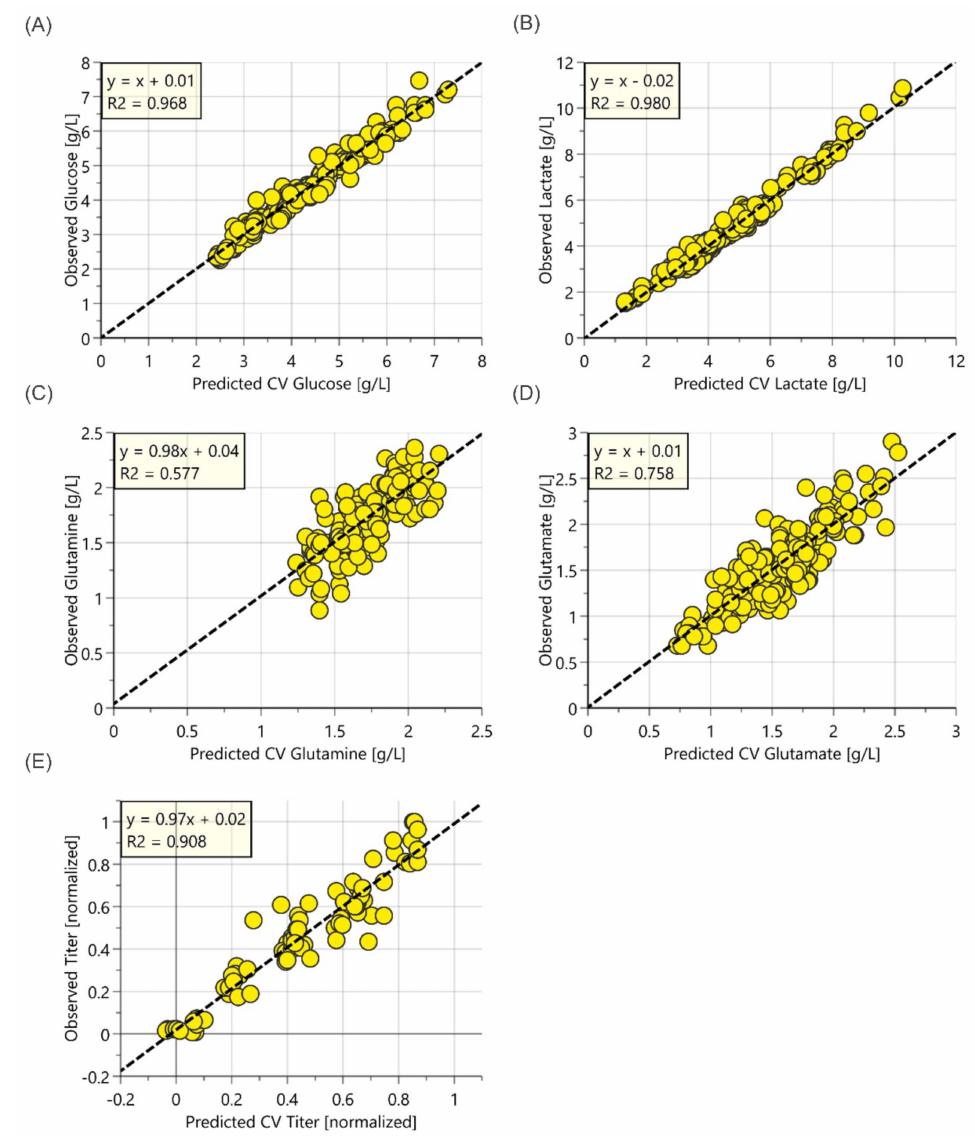
Figure 3. Parity plots of the observed values vs. predicted values from cross-validation for OPLS models of unspiked cell culture samples for ( A ) glucose, ( B ) lactate, ( C ) glutamine, ( D ) glutamate and ( E ) normalized titer with unspiked cell culture samples from 250 mL mini